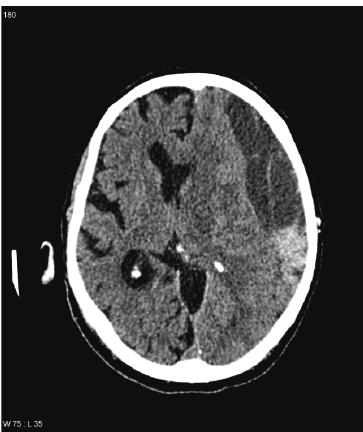
Figure 2: Computed tomography of a left-sided chronic subdural